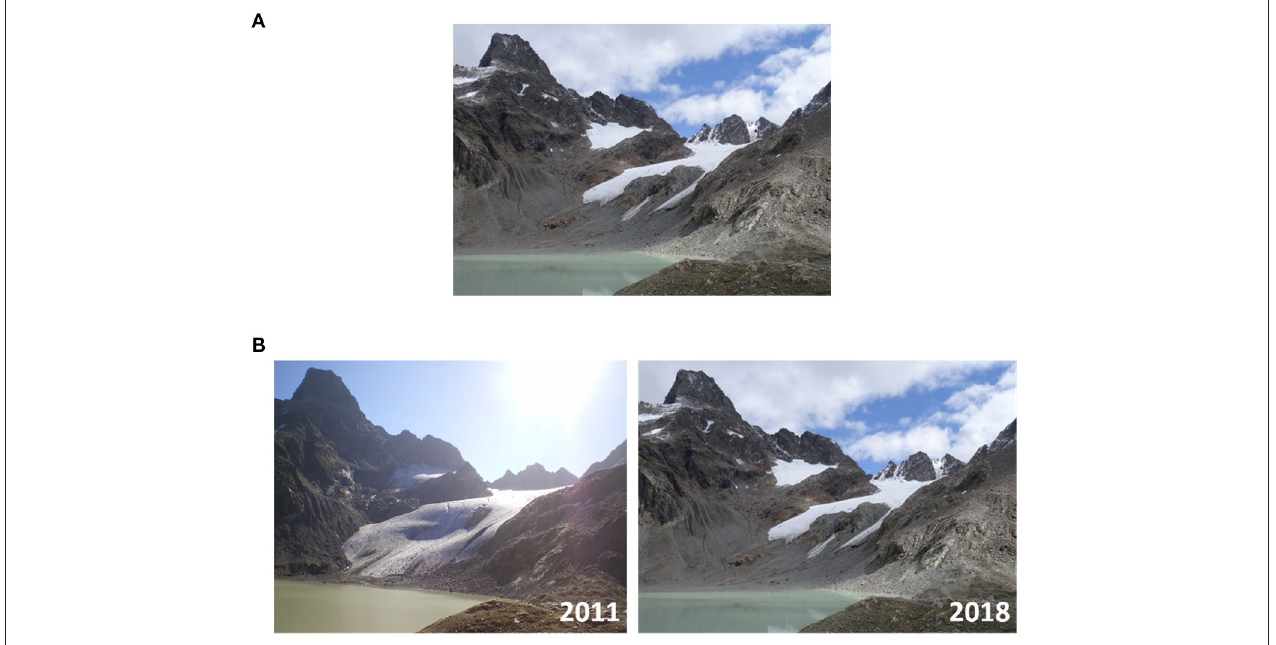
FIGURE 1 | Climate change unaffected scenario [ (A) , upper row] and climate change affected scenario [ (B) , lower row]. Pictures by courtesy and with kind permission of Austrian Alpine Association.